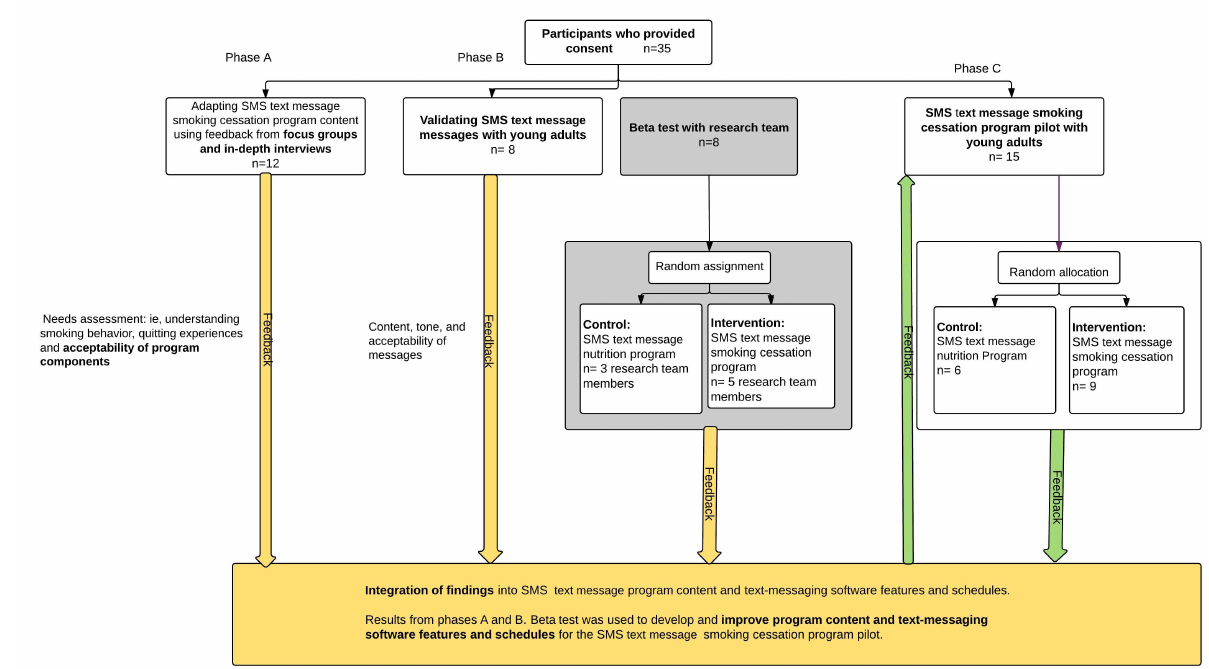
Figure 2. Program outline and participation in different phases of the